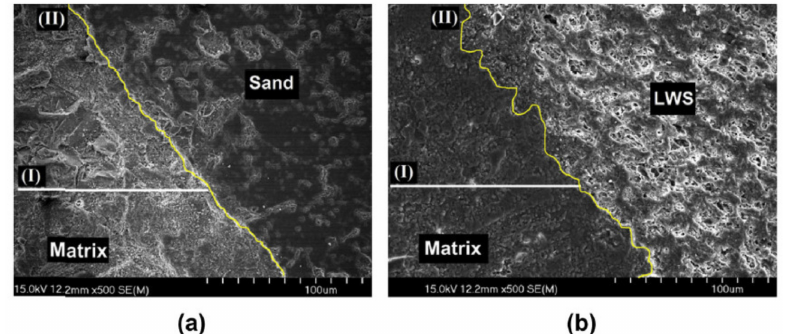
Figure 1. SEM images at 91 days for two di ff erent OPC-CSA mortar mixtures: ( a ) interfacial transition zones (ITZ) surrounding sand for OPC-CSA mixture made without light-weight sand (LWS) and ( b ) ITZ surrounding LWS for OPC-CSA mixture containing 20% LWS replacement [19], with copyright permission from